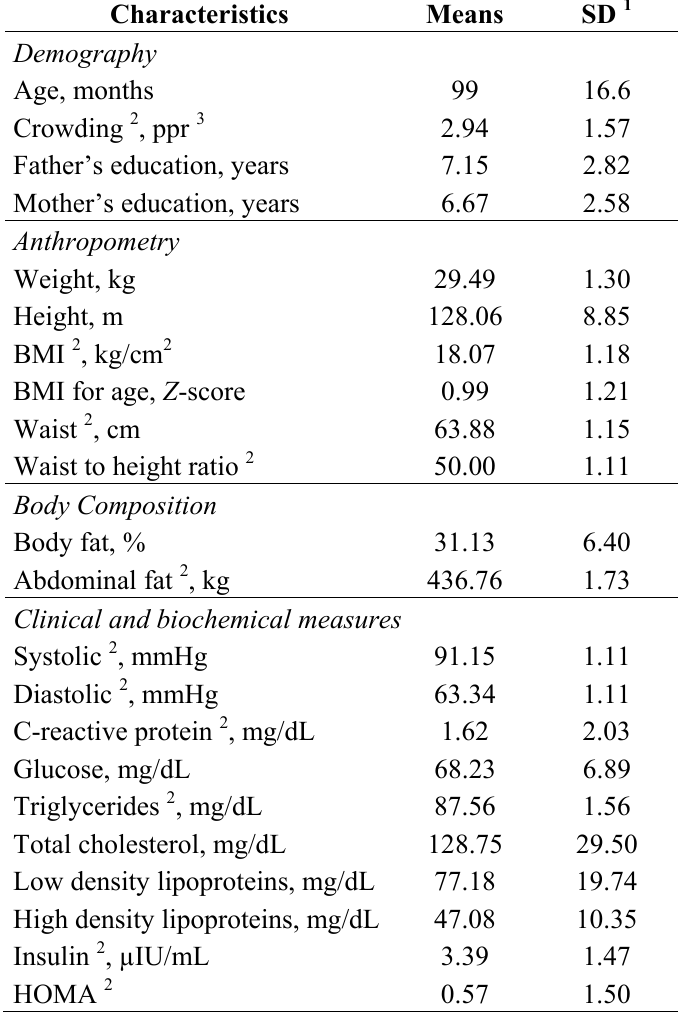
Table 1. General characteristics of the children that participated in the study according to their Body Mass Index (BMI) ( n = 197). HOMA, Homeostatic Model